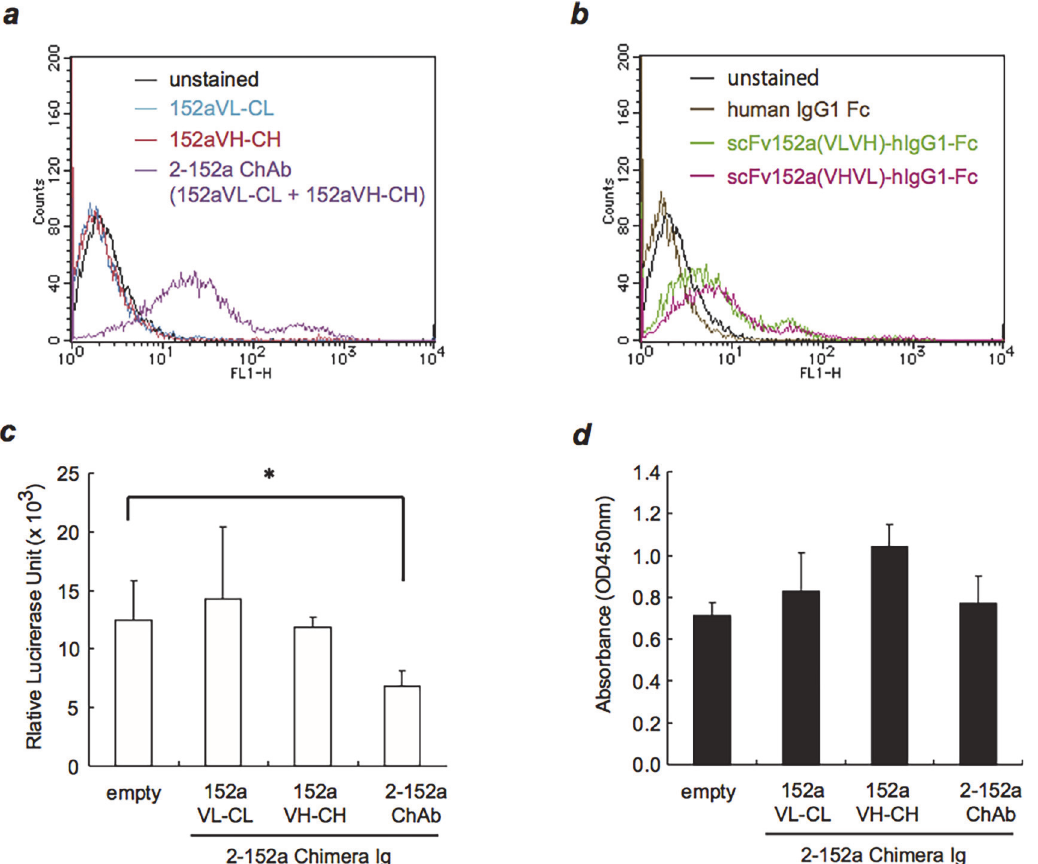
Fig 4. 152a ChAb can bind to surface DHCR24 and shows anti-HCV activity. ( a ) HuH-7 (1 × 10 6 ) cells were incubated with the light or heavy chain of the chimeric Ig (152a Ch-L, 152a Ch-H) or 152a ChAb (1 μ g/mL, respectively) at 4°C for 2 h, and then with an Alexa Fluor 488-conjugated goat anti-human IgG at 4°C for 1 h. The cells were then analyzed by flow cytometry. ( b ) HuH-7 (1 × 10 6 ) cells were incubated with 152a scFv-hIgG1-Fc at 4°C for 2 h, and then incubated with Alexa Fluor 488-conjugated goat anti-human IgG at 4°C for 1 h. The cells were then analyzed by flow cytometry. ( c ) Subgenomic HCV replicon FLR3-1 cells were plated in a 96-well plate at a density of 5 × 10 3 cells/well and allowed to adhere overnight. Then, the supernatant was removed, and the cells were treated with the light or heavy chain of the chimeric Ig (152a Ch-L, 152a Ch-H) or 152a ChAb (1 μ g/mL, respectively) for 72 h. HCV replication was evaluated by measuring luciferase activity using the Bright-Glo Luciferase Assay System. * , p < 0.05. ( d ) Simultaneously, the viability of FLR3-1 cells was evaluated by measuring the absorbance (OD at 450 nm) using the WST-8 Cell Counting Kit. Experiments were performed 3 times with triplicate